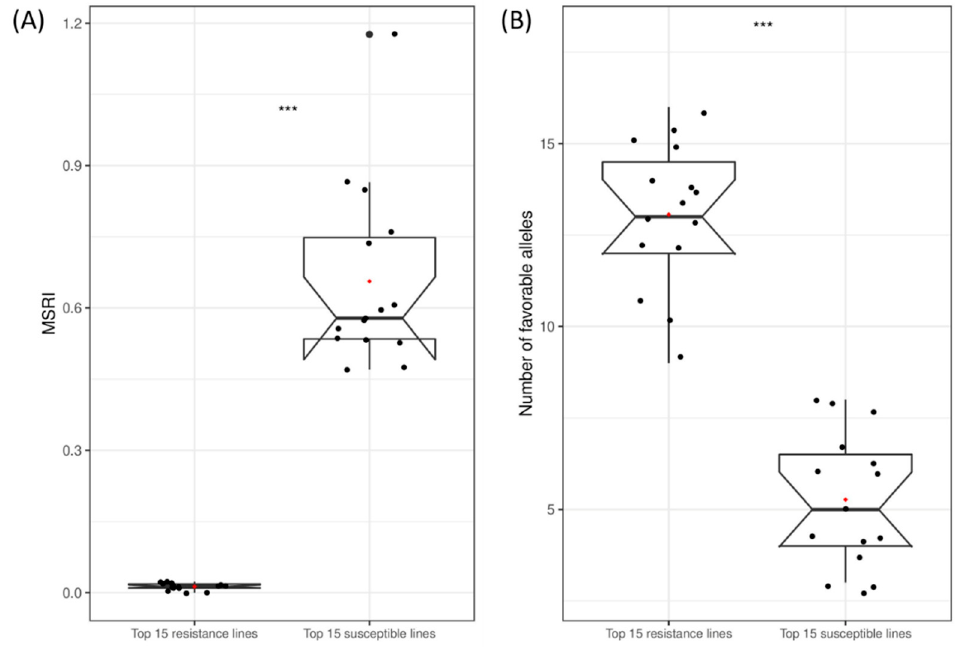
Figure 8. Boxplots of marsh spot resistance index (MSRI) ( A ) and the number of favorable alleles ( B ) for the 15 most resistant lines and the 15 most susceptible lines. ***: p < 0.0001. In each box plot, the black dots represent data points and the red dot represents the mean of the data points.